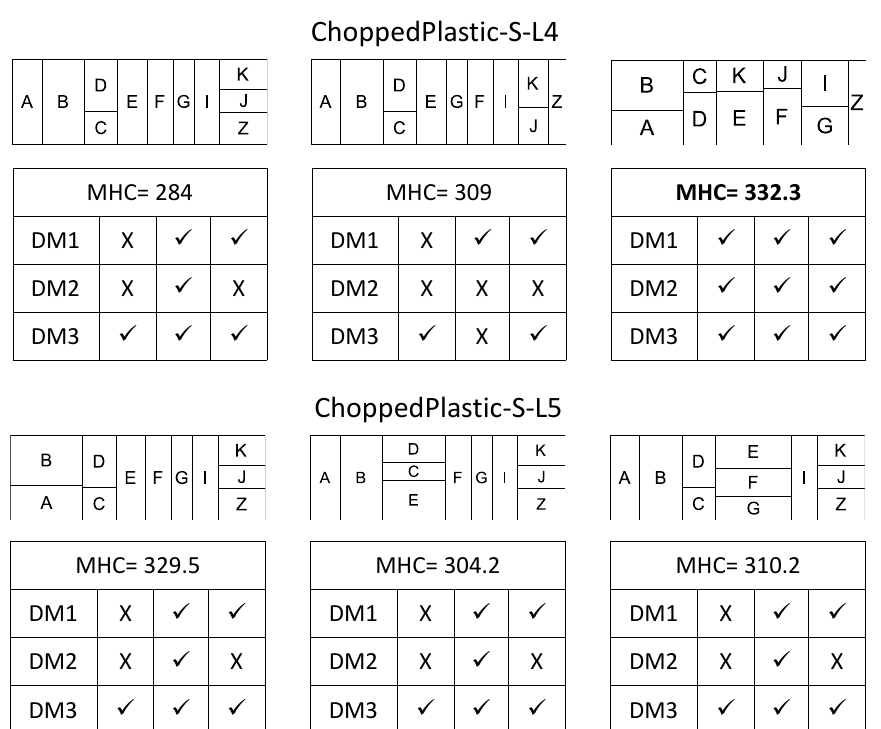
Figure 18. Best solutions found in Sequential launch 4 to 5 of ChoppedPlastic